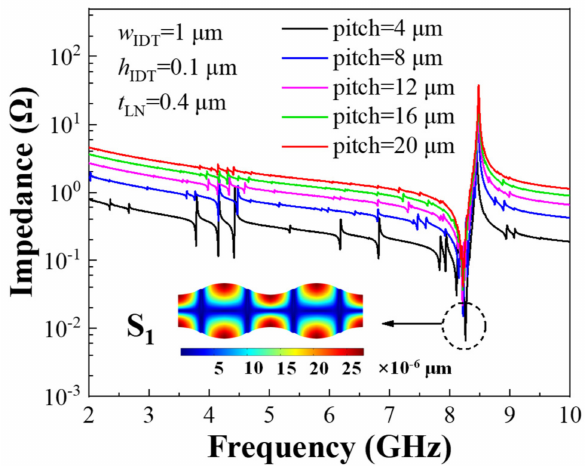
Figure 2. Impedance curves of resonators with different IDT pitches; the inset is the resonator displacement at resonance frequency.